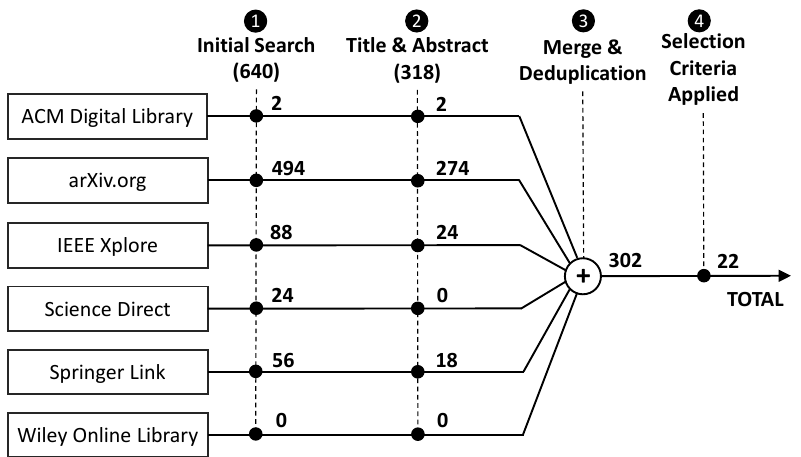
Figure 3. Overview of the search and filtering process (based on